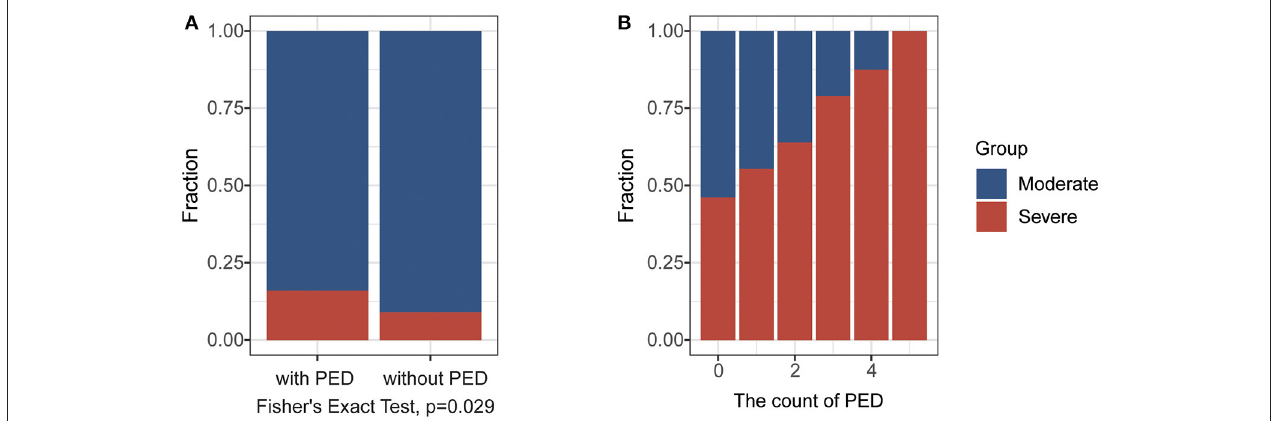
FIGURE 2 | The impact of the pre-existing disease (PED) on the progression of COVID-19. (A) The fraction of severe cases in patients with or without in PED in the FPHJ-548 dataset. The red represents the severe COVID-19 patients and the blue represents moderate COVID-19 patients. (B) The fraction of severe cases in patients with different numbers of PEDin HSSH-3015 dataset. The red represents the severe COVID-19 patients and the blue represents moderate COVID-19 patients.